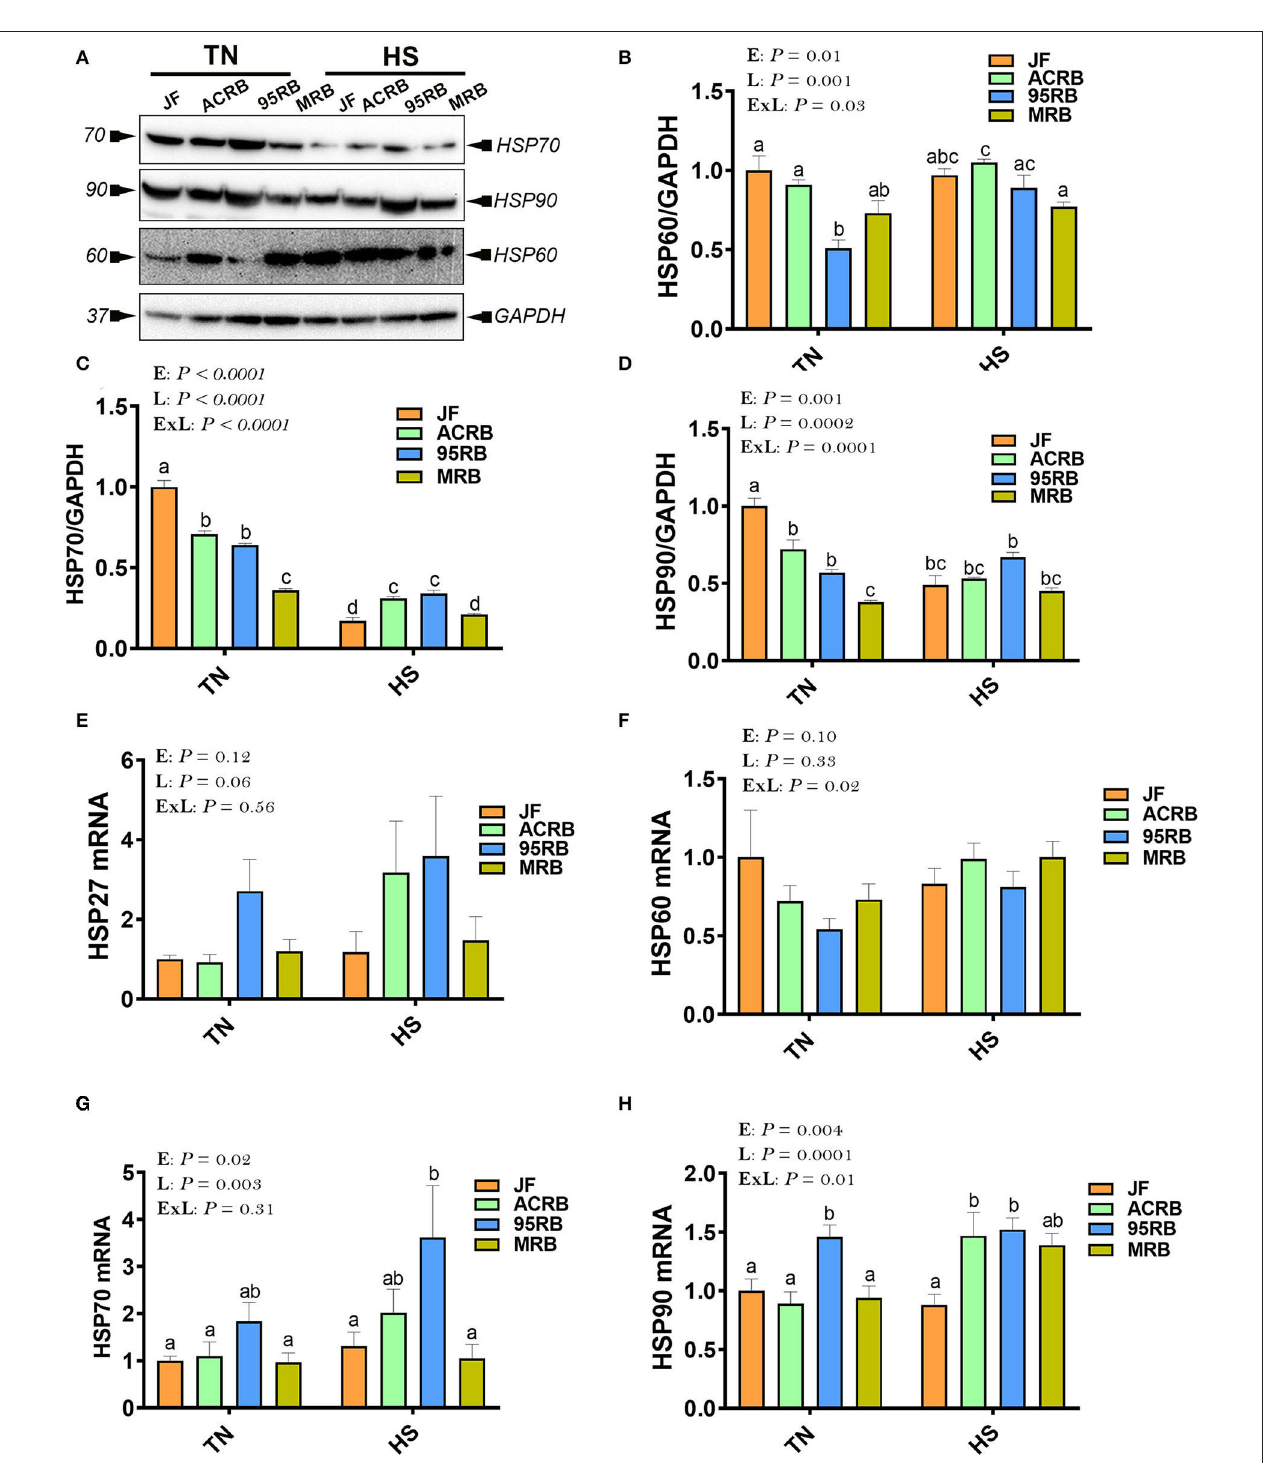
FIGURE 6 | Effect of HS on hypothalamic expression of HSPs in three modern broilers and their ancestor JF. Protein and RNA were extracted from hypothalamic tissues and analyzed by western blot (A–D) and qPCR (E–H) , respectively. Gene expression was determined by qPCR using 2 − 11 CT method and data are mean ± SEM ( n = 6/group). Protein expression was presented as target protein/GAPDH (A–D) . Protein was analyzed via AlphaVIew software and is expressed as mean ± SEM ( n = 3/group) with one representative blot shown (A) . Different letters indicate significant difference at P < 0.05. 95RAN, 1995 random bred; ACRB, Athens Canadian Random Bred; E, environment; ExL, interaction between E and L; HS, heat stress (36 ◦ C); HSP, heat shock protein; JF, jungle fowl; L, line; MRB, modern random bred; TN, thermoneutral (25 ◦ C).